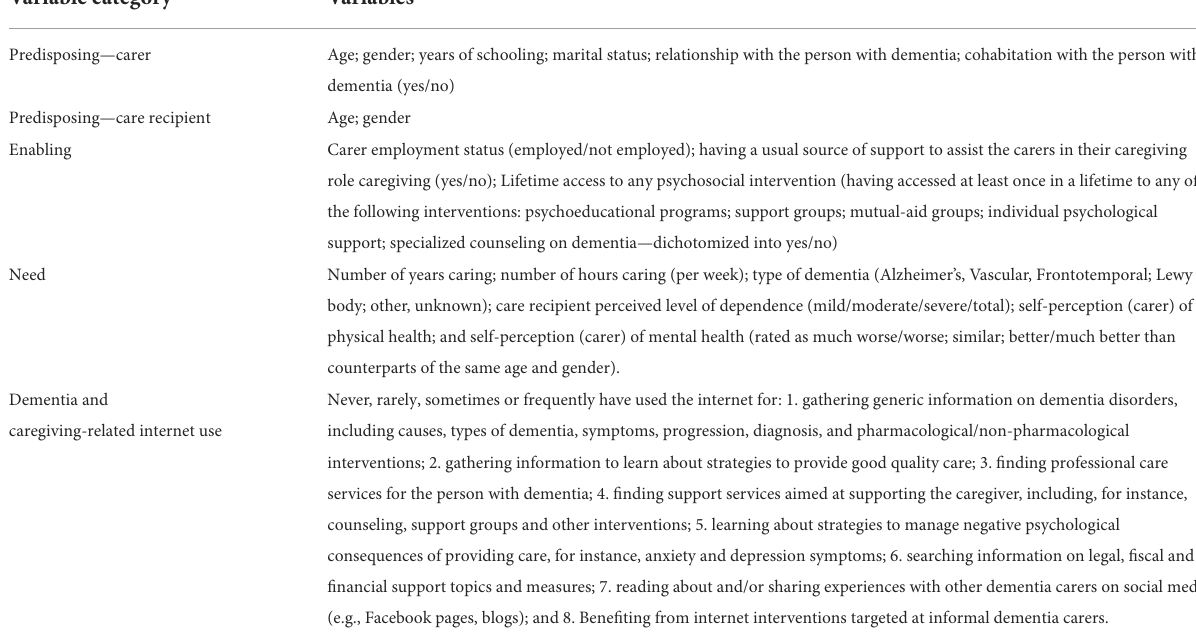
TABLE 1 e-Survey: variables covered and retrieved for this study. Variable